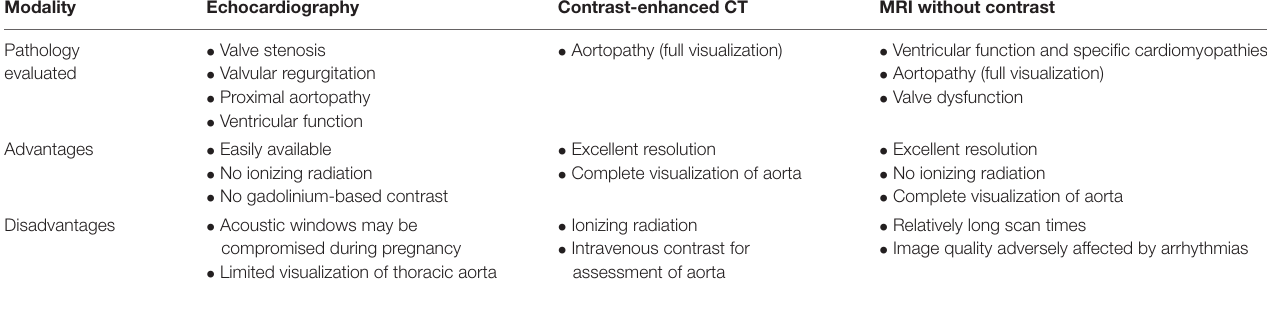
TABLE 1 | The advantages and the disadvantages of each imaging modality in pregnancy.